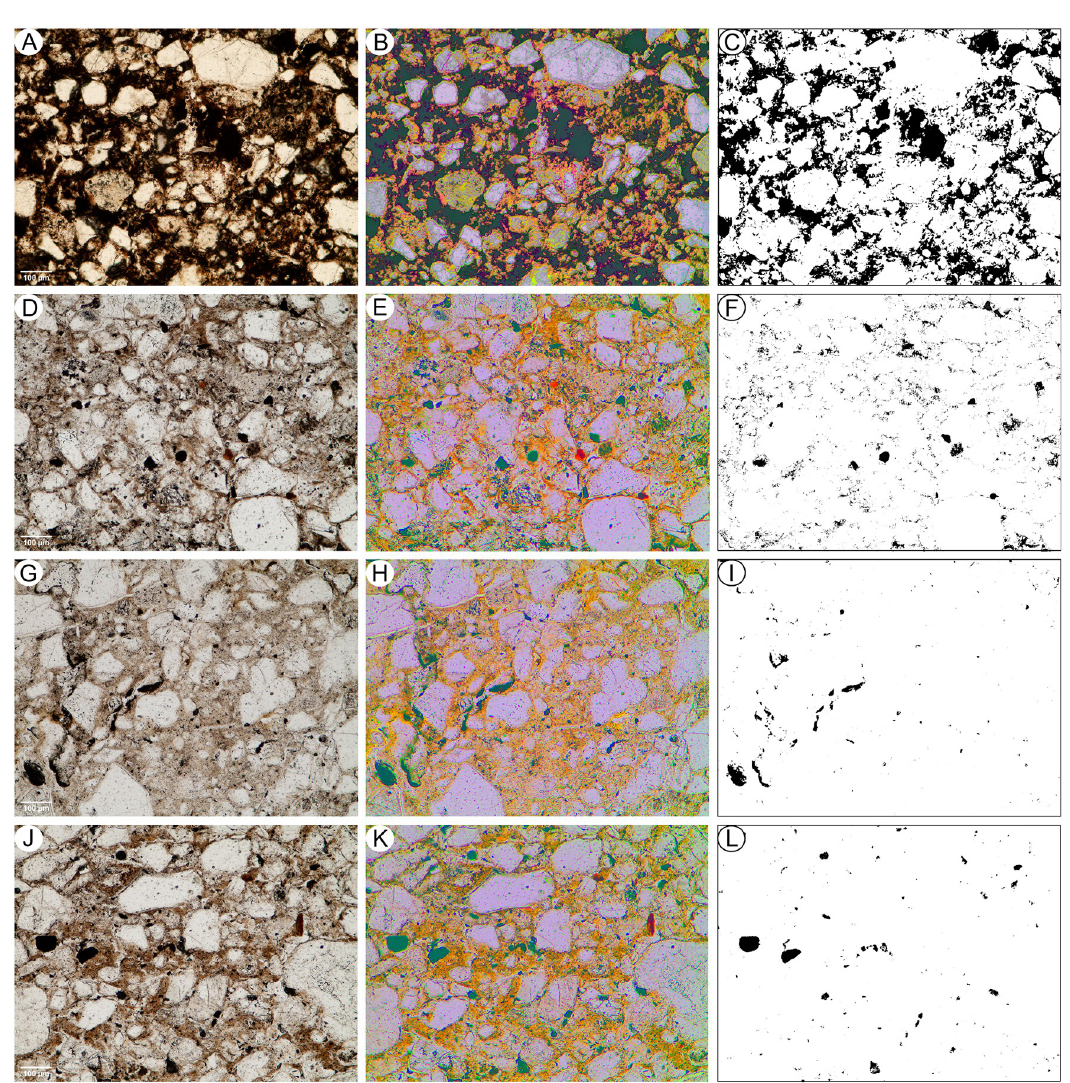
Fig 9. Distribution and size of amorphous organic matter aggregates (AOM) in the Amanzi Springs Area 1 sediments. Left column: thin sections microphotographs (PPL). Central column: results of microphotograph decorrelation stretching (stretching = 0.01); green: AOM; yellow to orange-red: increasingly impregnated Fe-oxide pedofeatures and micromass; blue: Mn oxides; some colour change near the margins is due to uneven illumination (not visible in normal conditions). Right column: AOM aggregates after extraction by ImageJ colour thresholding. A-C: DMHS (sample AMZ17/5/1), with dominant large AOM aggregates. D-F: LMHS (sample AMZ17/1/3-5, lower part), with isolated medium/small-size aggregates and very fine AOM punctuation around mineral grains. G-I: northern facies of LMHS (LMHS-N, sample AMZ17/2/3-4), with few relatively large AOM aggregates and abundant fine silt/clay. J-L: BHS (sample AMZ17/1/3-5 upper part), with unsorted few to common AOM aggregates in locally Fe- impregnated clay-rich